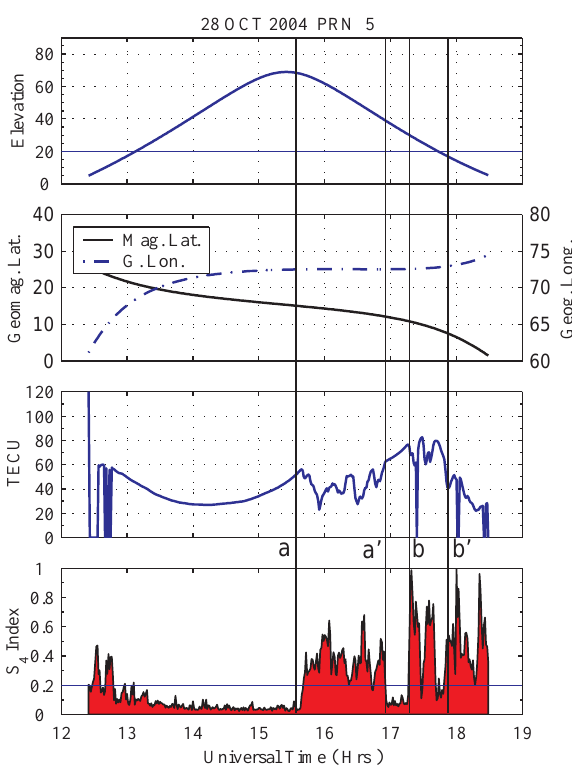
Fig. 4. Variation of TEC and S 4 index on 28 October 2004 for satellite PRN 30. Again, a series of depletions in TEC are observed. As in previous cases, here also, the S 4 index is high only when the depletions in TEC occur. The rest of the labels are the same as in Fig.